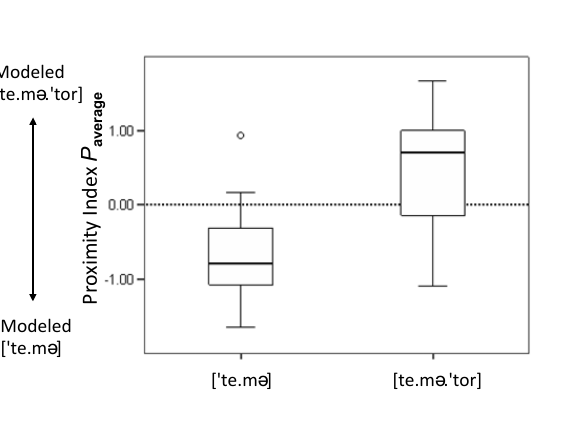
Figure 5. Box plots for the averaged proximity indices P average of naturally produced tokens to modeled